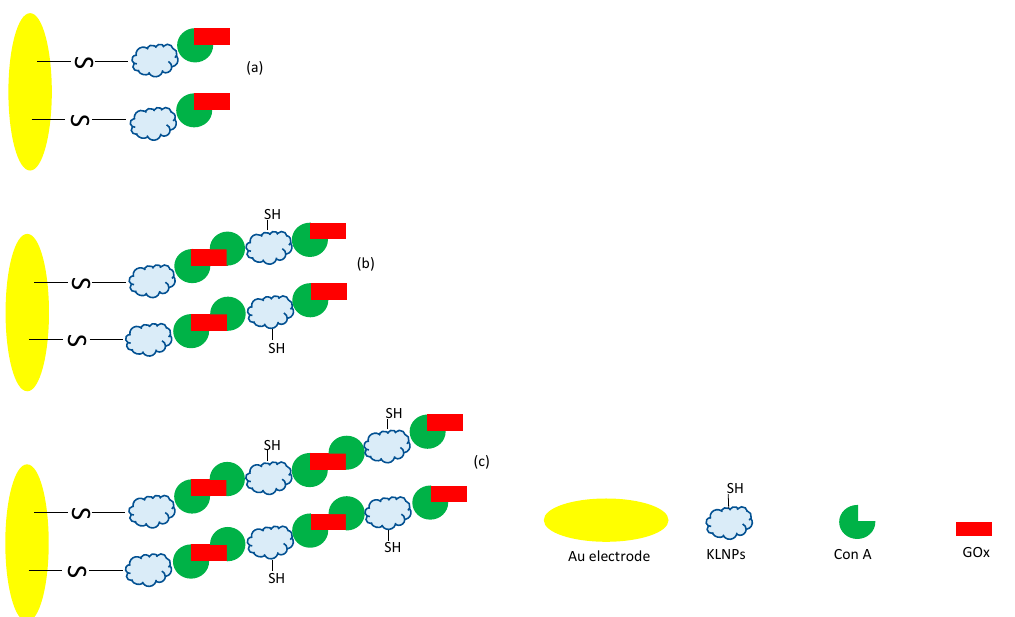
Scheme 3. Schematic of the layer-by-layer (LbL) deposition process. Gold electrodes were successively functionalized with one ( a ), two ( b ) and three ( c ) layers of KLNPs, ConA and GOx by direct adsorption.